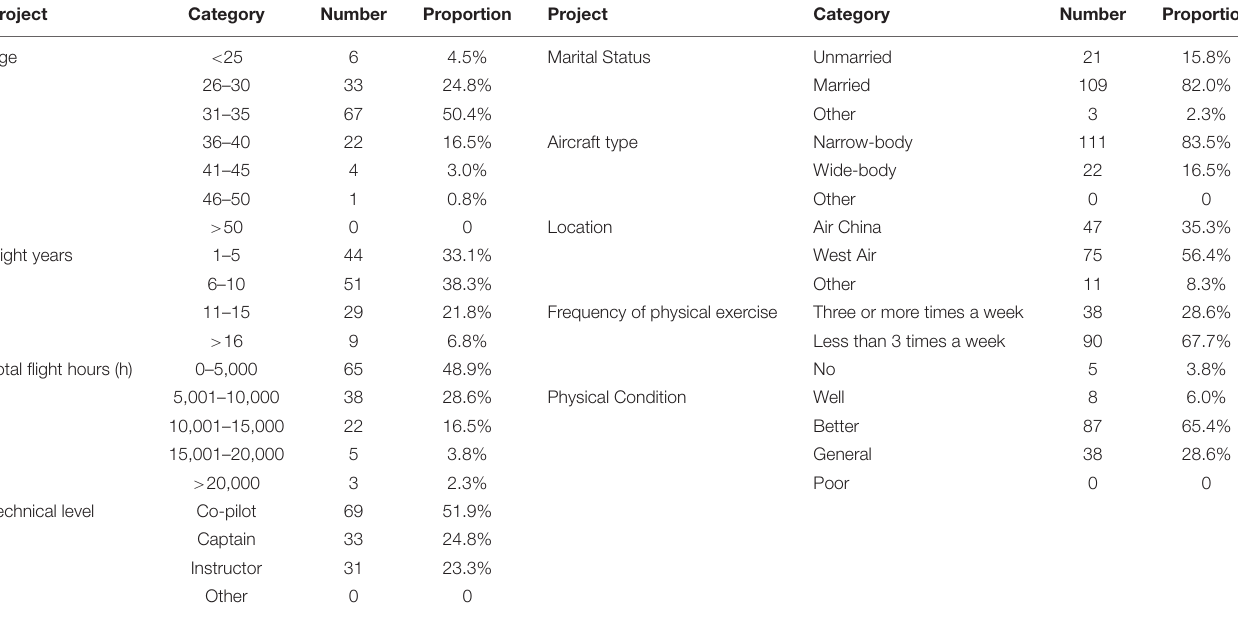
TABLE 1 | Basic personal information statistics of airline pilots.